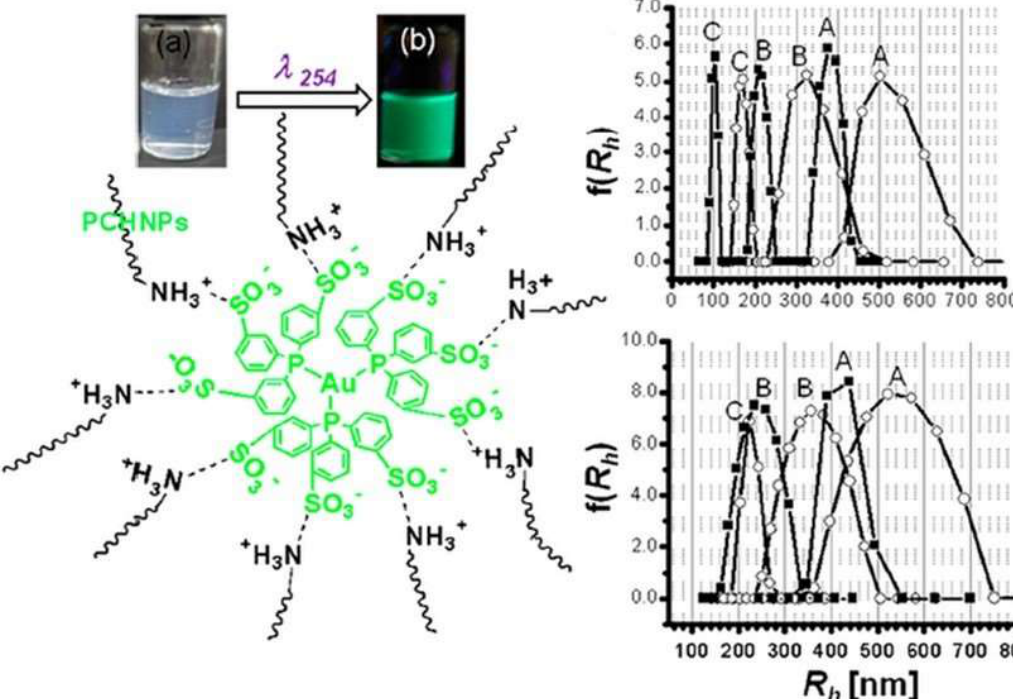
Figure 4. Schematic illustration for the formation of phosphorescent CS nanoparticles using Au(I) molecular system as a crosslinker. The light scattering data demonstrates the formation of size-tunable particles. Figure ( a ) CS nanoparticles in day light, ( b ) CS nanoparticles on excitation with UV lamp. A, B, C represents varying concentrations of Au(I) molecular system and CS polymer during synthesis of phosphorescent CS nanoparticles. Reprinted with permission from J. Phys. Chem. C 2015 , 119 , 12551–12561, Copyright 2015, American Chemical Society [46].